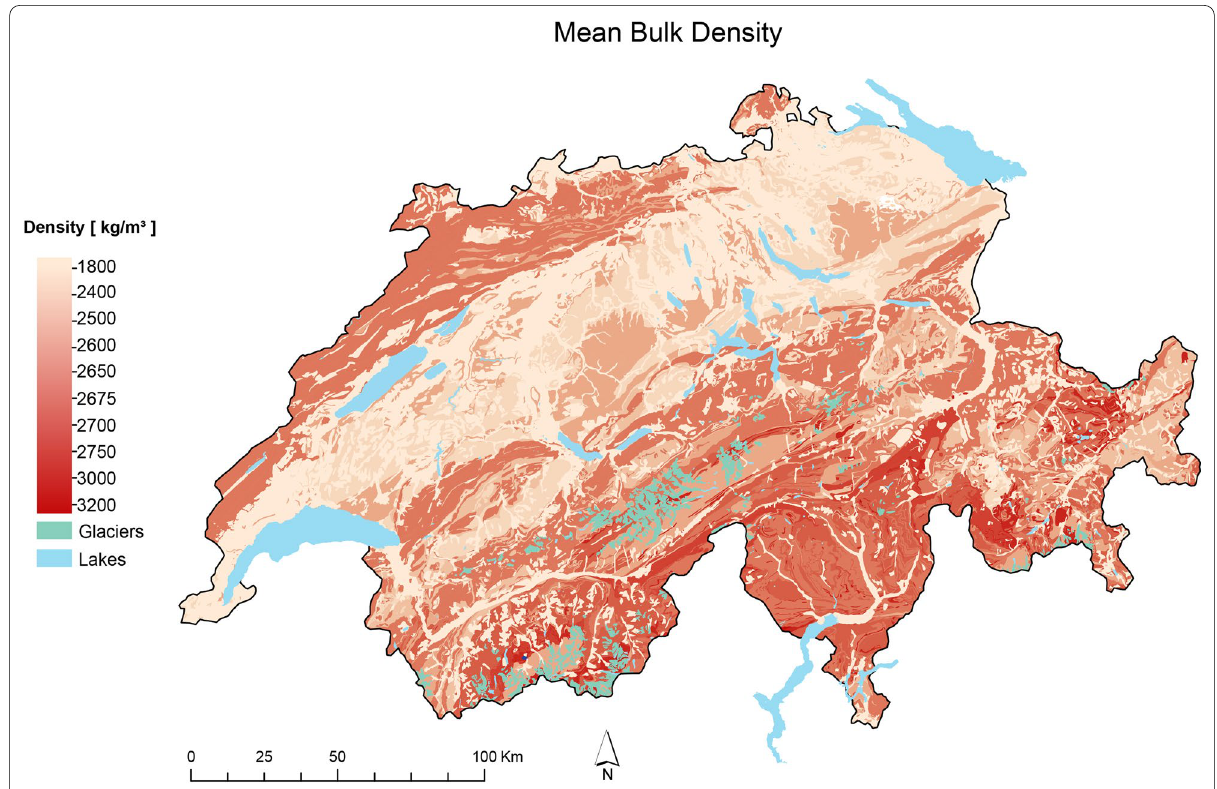
Fig. 11 Mean bulk density distribution in surface rocks of